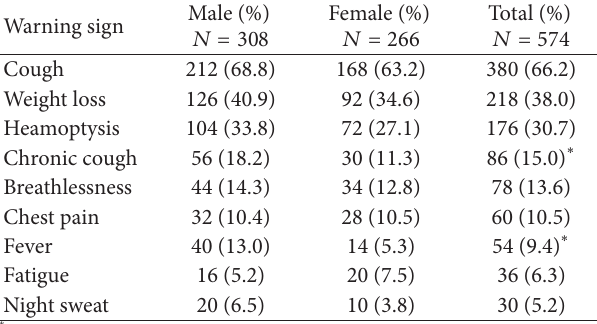
T 2: Identi�ed TB warning sign according to gender.